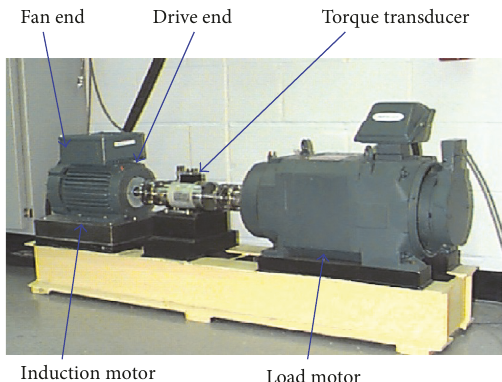
Figure 11: The bearing test rig of